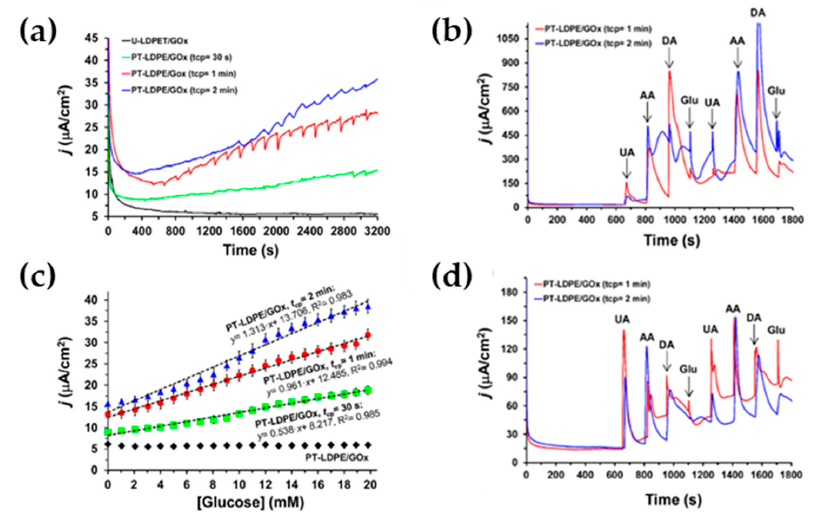
Figure 17. ( a ) Current–time plots for the untreated low-density polyethylene (U-LDPE) / glucose oxidase (GOx) and treated low-density polyethylene (PT- LDPE) / GOx (t cp = 30 s, 1 and 2 min) upon the successive addition in 0.1-M PBS of 1 mM glucose; ( b ) current–density response versus glucose concentration for the three sensors mentioned above. Error bars indicate standard deviations for five measurements using independent electrodes. The calibration curve equation is also displayed. Current–time plots for the PT-LDPE / GOx sensors (t cp = 1 and 2 min in red and blue, respectively) upon the successive addition in 0.1-M PBS of: ( c ) 1 mM glucose, 1 mM uric acid (UA), 1 mM ascorbic acid (AA) and 1 mM dopamine (DA); ( d ) 1 mM glucose, 0.1 mM UA, 0.1 mM AA and 0.1 mM DA. Polarization